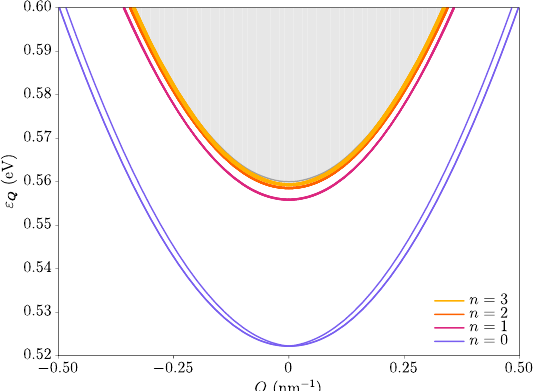
Figure 6. Excitonic dispersion relation for the Coulomb potential in the trivial regime. Here the different colors simply label the principal quantum number n . Up to numerical error, at Q 4 ( 2 n 1 ) , consistent with the fact that there are four exciton families each having angular degeneracy g n = + n , . . . , 0, . . . , n momentum m . The binding energies at the origin follow the hydrogenic Rydberg series ∈ {− } 2 . This plot has been obtained by using the same parameters for the underlying single-particle − model but changing the sign of B 2 , which produces a zero Chern number for the electrons and holes (see the “Methods” section).